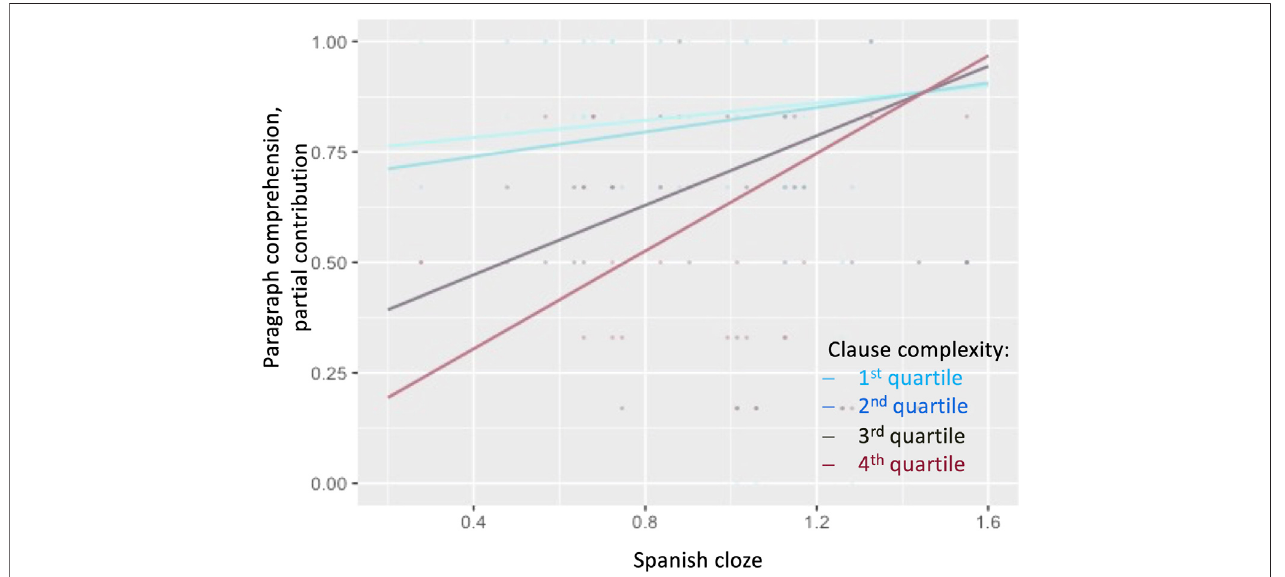
FIGURE3| Model 2.3displayingthe relationship ofL1 Spanish clozeskillswithparagraph comprehensionfordifferent quartilesofclause complexity ( β (cid:1) 0.19, p < 0.001).